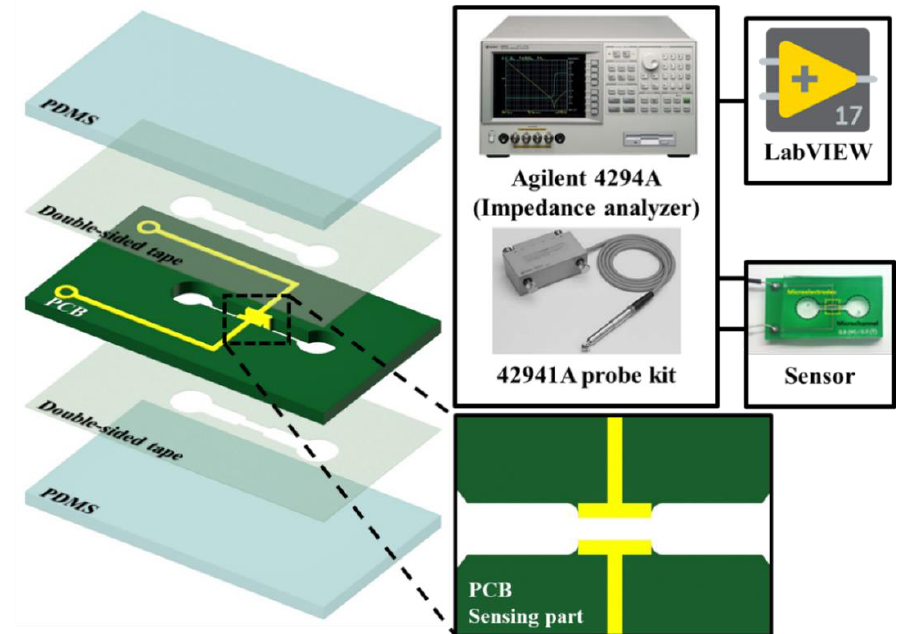
Figure 1. Schematic view of the proposed system. In the case of the temperature-dependence test, an impedance analyzer equipped with an impedance probe kit is connected to the electrode part of the sensor. The impedance is obtained by sweeping the AC voltage frequency (0.5 V, 1 kHz to 110 MHz) of the connected impedance analyzer while the sample flows in the channel. The entire system is controlled using software based on the LabVIEW program.